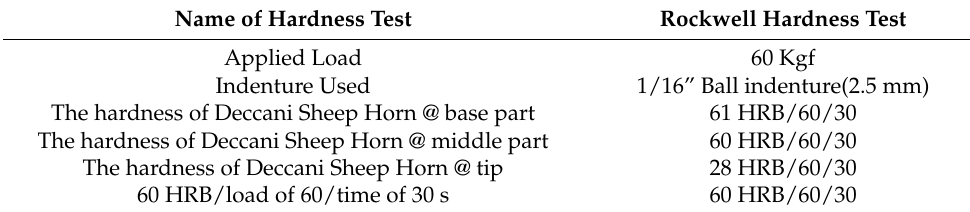
Table 10. Rockwell hardness test load and results for Deccani sheep horns.